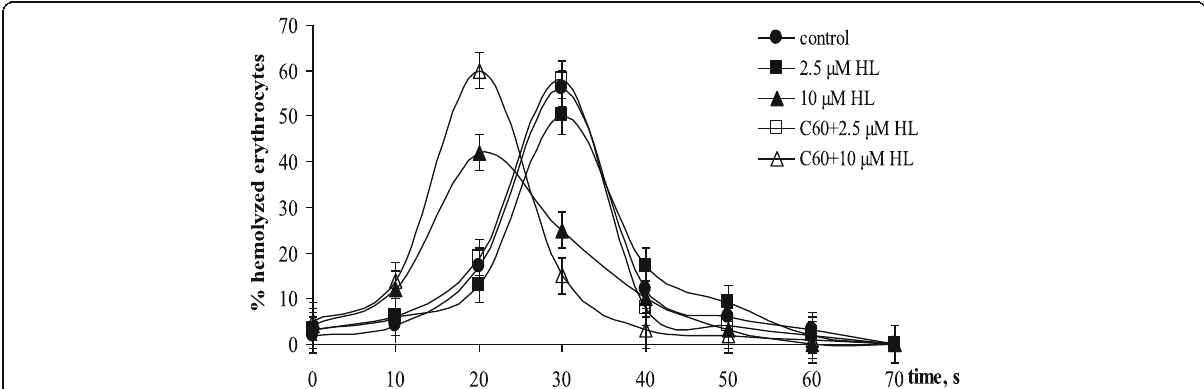
Fig. 7 Erythrocytes resistance to hemolysis in the presence of diphenyl-N-(trichloroacetyl)-amidophosphate (HL) separately and in combination with 16 μ M C 60 fullerene. (M±m, n